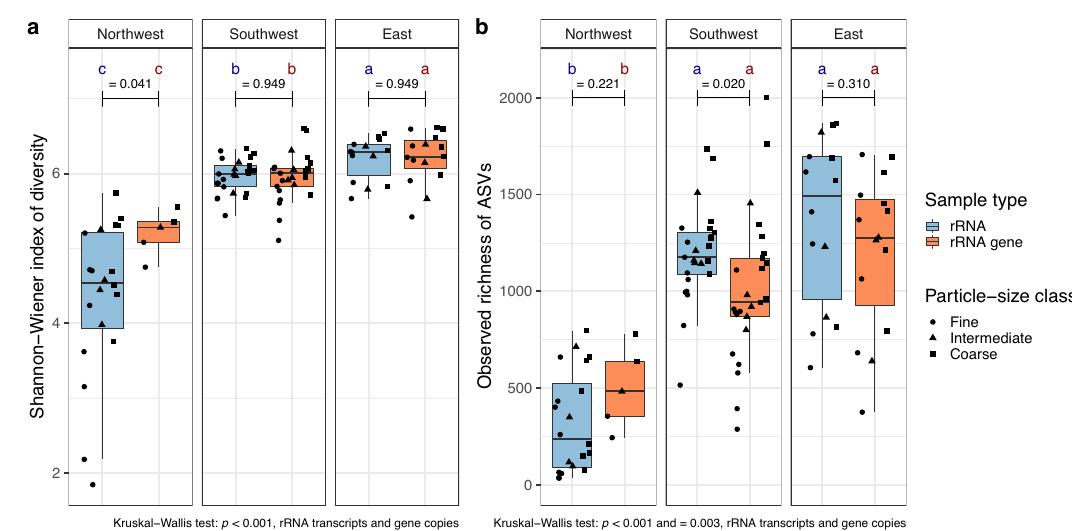
Fig. 1 Diversity and richness of airborne bacterial communities. Shannon – Wiener diversity indices ( a ), and observed richness ( b ) of rRNA and rRNA-gene communities of different air masses. Community type and particle-size classes are represented by different colors and symbol shapes, respectively. Box plot center lines represent the median values, the lower and upper hinges correspond to the fi rst and third quartiles (the 25th and 75th percentiles), the lower and upper whisker extends from the hinge to the lowest and largest value no further than 1.5 * IQR (interquartile range) from the hinge, and dots represent individual samples within each group. Lowercase letters indicate statistically signi fi cant differences ( p < 0.05) between the air masses for rRNA and rRNA-gene communities separately. p values of signi fi cance between rRNA and rRNA-gene communities in each air mass are displayed over the horizontal bars in each